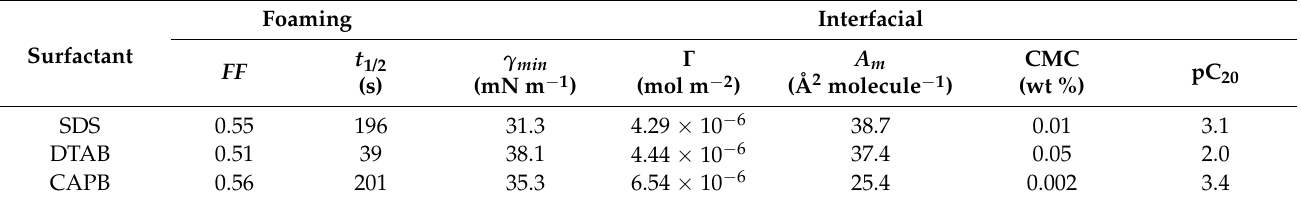
Table 3. Interfacial and CO 2 foam properties of surfactant formulations in brine ( FF :